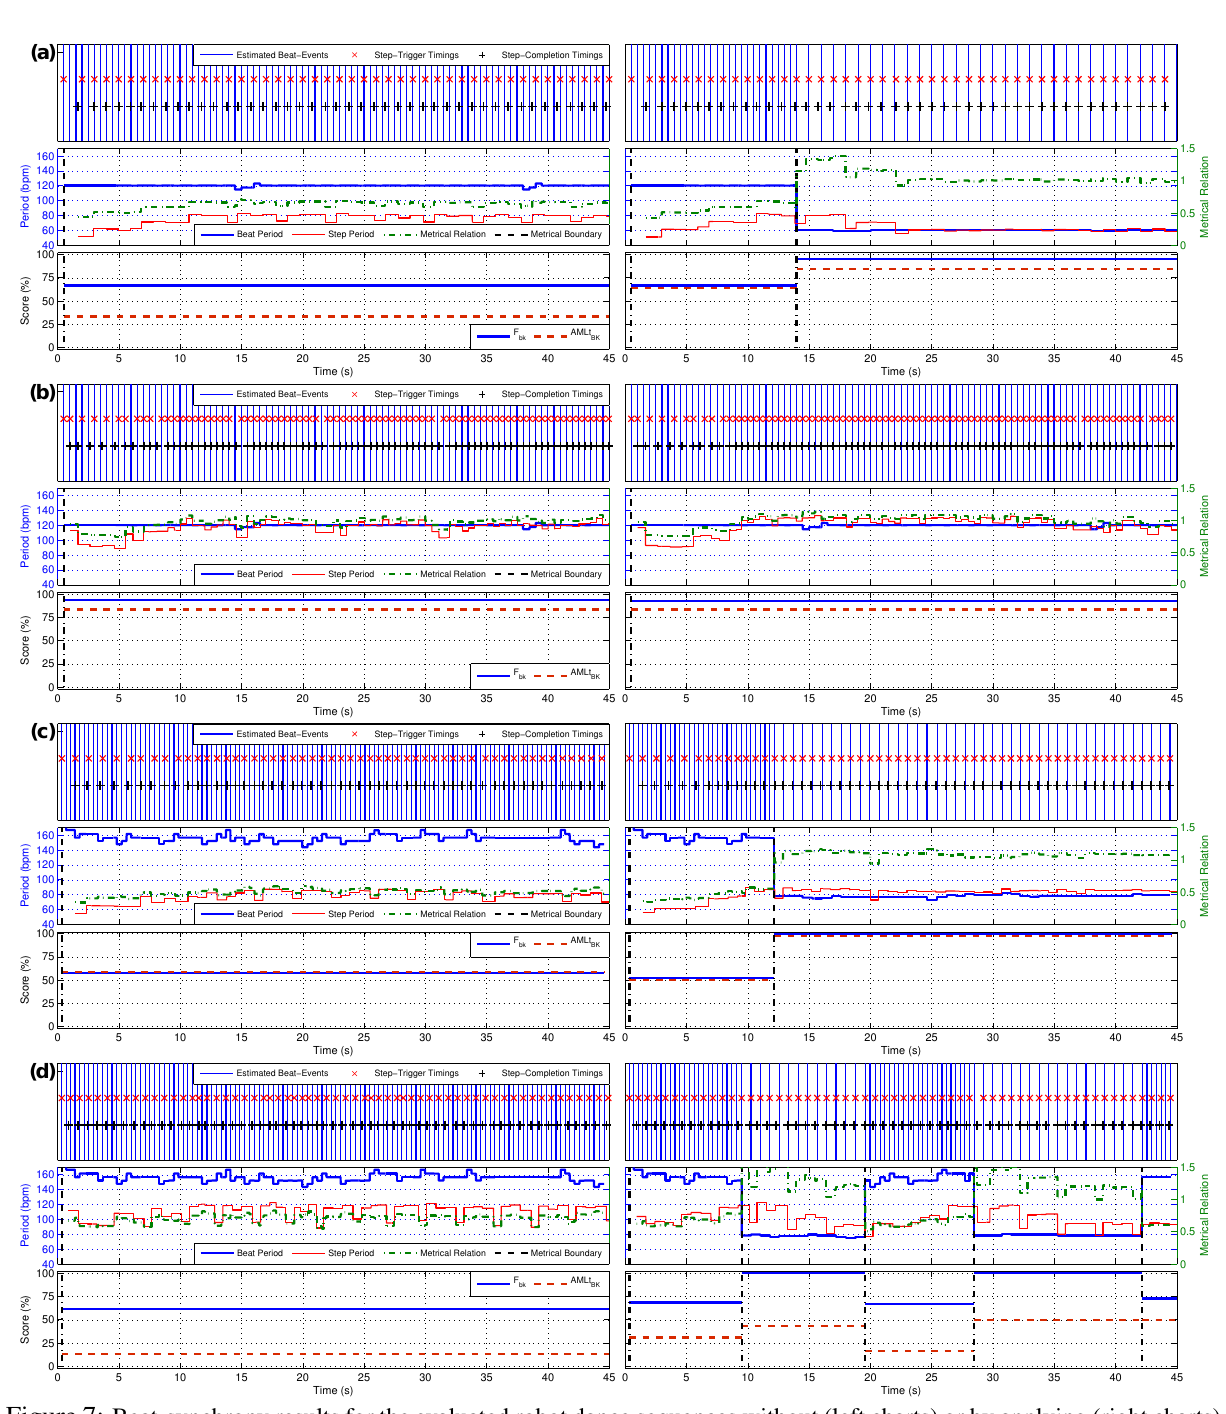
Figure 7: Beat-synchrony results for the evaluated robot dance sequences without (left charts) or by applying (right charts) metrical-level changes: (a) mov1 with musicC ; (b) mov2 with musicC ; (c) mov1 with musicV ; (d) mov2 with musicV . The top charts depict the phase-synchrony between the step-trigger and the step-completion timings against the estimated beat- events. The middle charts depict the period-synchrony between the step period and beat period, and their metrical relation. The bottom charts depict the F bk and AML BK beat-synchrony results per metrical relation between the step and beat